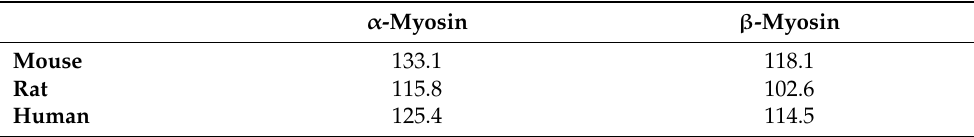
Table 3. Isometric tension (kPa) at [Ca 2+ ] = 10 µ M.